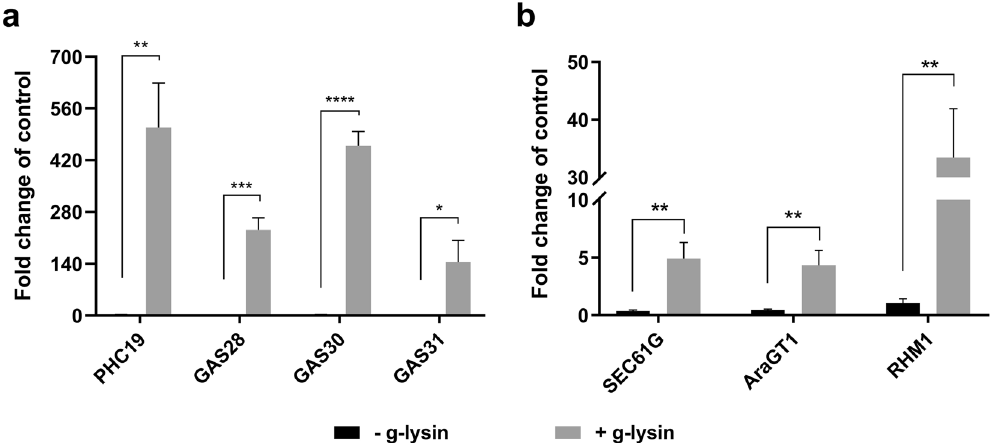
Figure 1. Transcription of CW genes in response to gametolysin treatment shows global upregulation. ( a , b ) Bar graphs represent the change in expression for cell wall protein-encoding ( a ) and protein processing-related ( b ) genes in wild type (CC-125) cells. Untreated control samples are represented by black bars, grey bars represent cells treated with g-lysin. Gene expression is quantified in terms of fold change compared to the samples before the g-lysin treatment. Error bars represent one standard deviation from the mean of biological triplicate samples. Welch’s t-test indicates statistical significance at p ≤ 0.05 ( * ), p ≤ 0.01 ( ** ), p ≤ 0.001 ( *** ), p ≤ 0.0001 ( **** ); α =